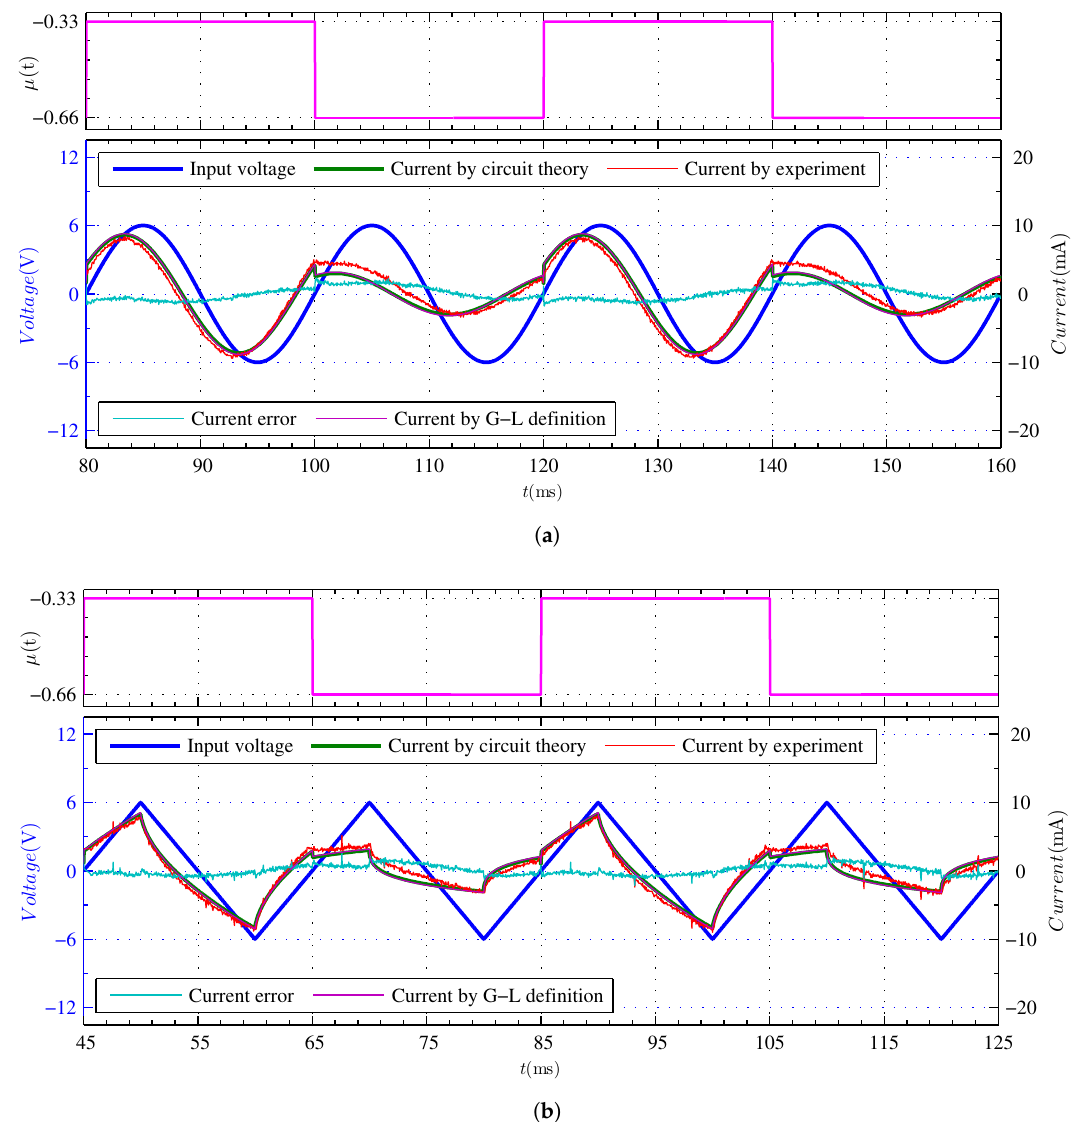
Figure 7. Experimental results of VSFF of dynamic variable-order: ( a ) sine wave; ( b ) triangular wave.